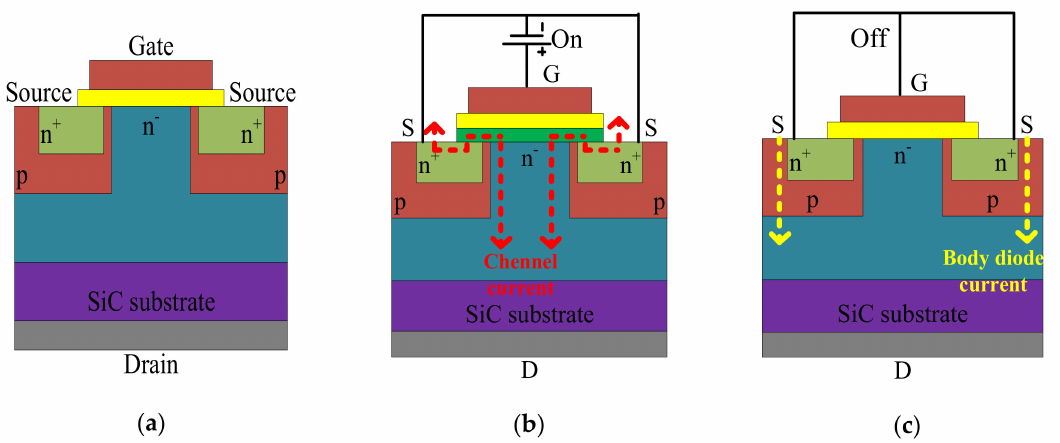
Figure 5. Schematic diagrams of a SiC MOSFET, ( a ) basic structure, ( b ) the gate-source voltage and current path in on-state, ( c ) the gate-source voltage and current path in